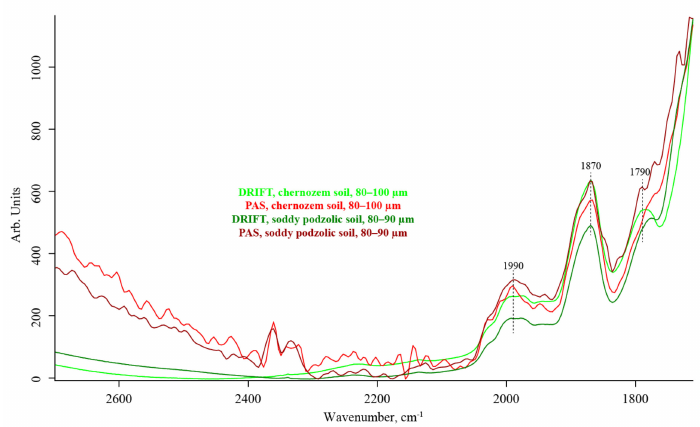
Figure 7. Normalized FTIR spectra in 2700–1700 cm − 1 . DRIFT and PAS (IMF 1.6 kHz) spectra of shelterbelt chernozem soil (dry fractionation, 80–100 µ m), light green and light red, respectively; and DRIFT and PAS (IMF 1.6 kHz) spectra of sod-podzolic soil (dry fractionation, 80–90 µ m), dark green and dark red, respectively.